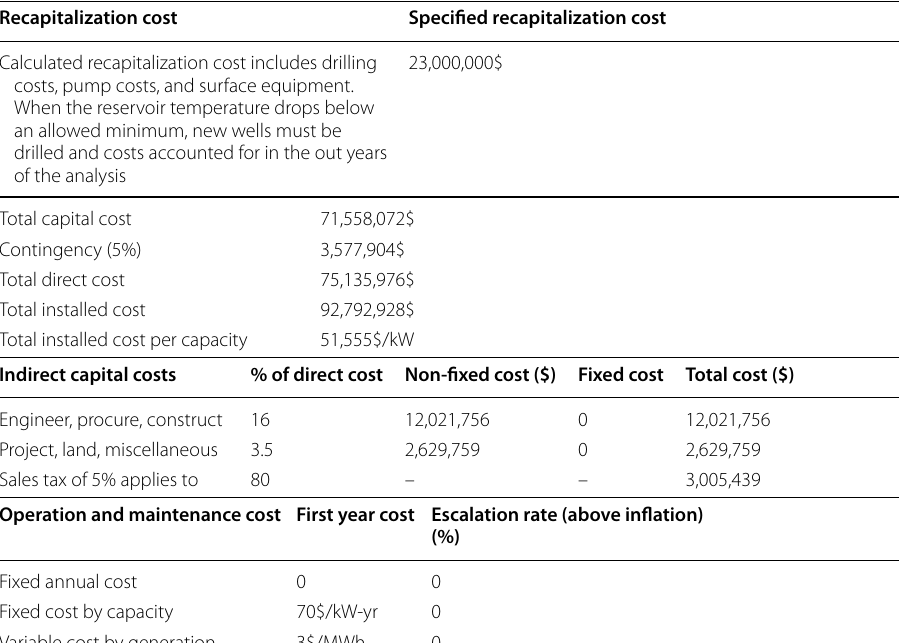
Table 4 Financial model dialog for the geothermal well Recapitalization